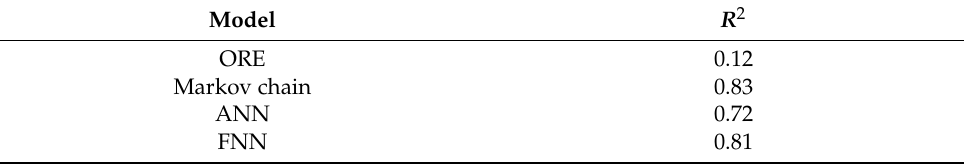
Table 3. The comparisons of Markov chain, ANN, FNN, and ORE models. Adapted from